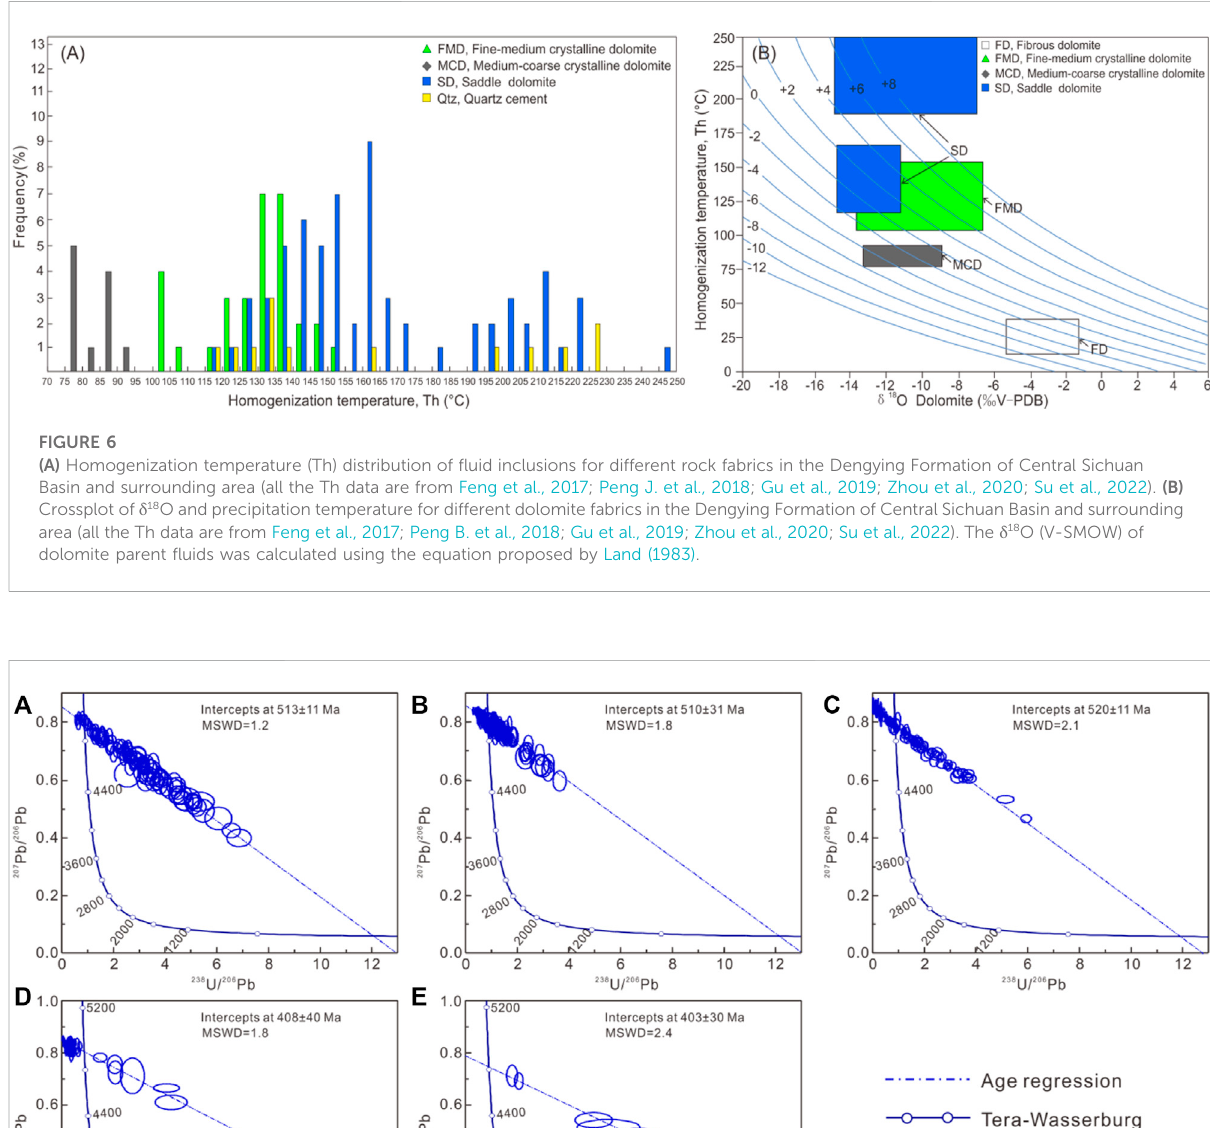
(Figure 5). At the same time, its Th is also within the normal range of the early diagenetic stage and is not signi fi cantly higher